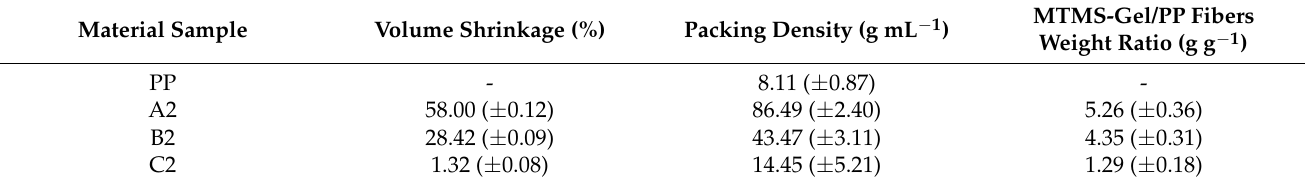
Table 1. Characterization of PP non-woven mat and PP-reinforced MTMS-based